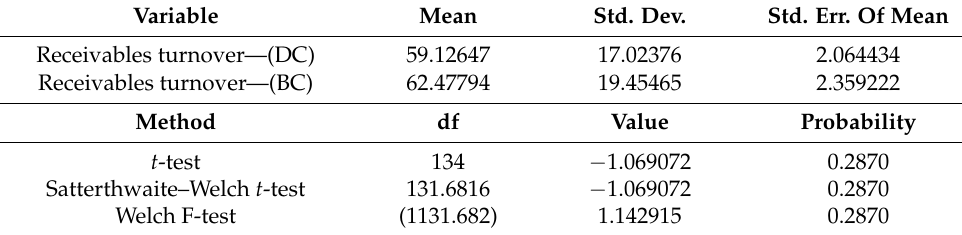
Table 7. The result of short-term receivables turnover.